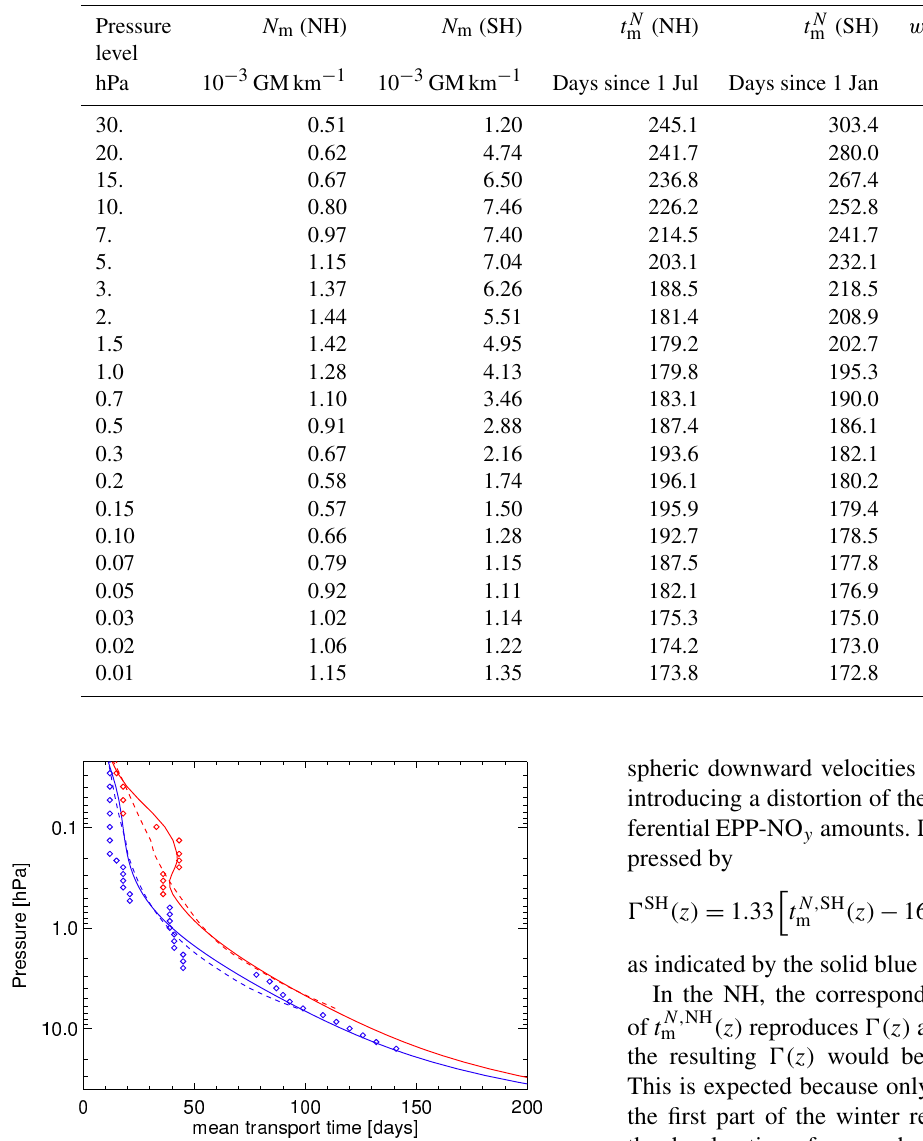
Table 1. Parameters N m , t N m , and w N of the empirical model for the vertical and temporal distributions of EPP-NO y differential amounts (see Eq. 5).